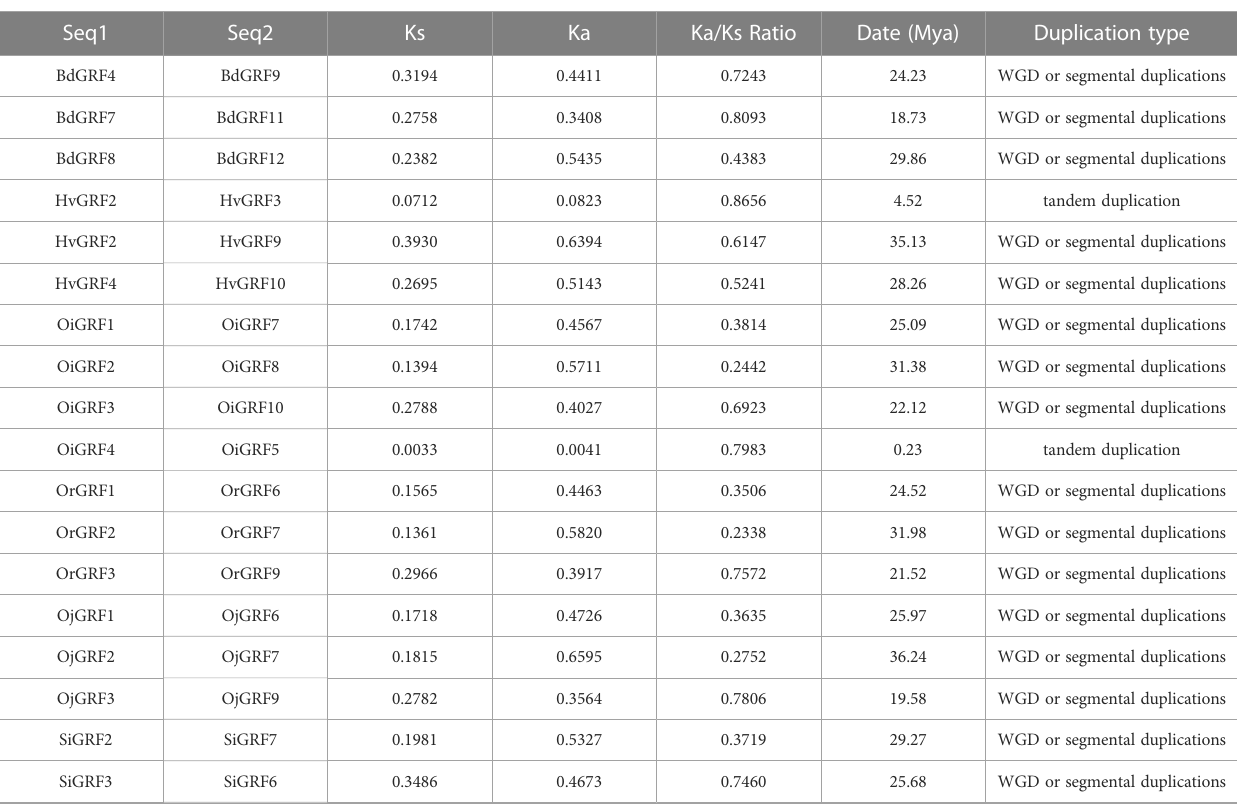
TABLE 1 Ka and Ks values for the duplicated gene pairs in Gramineae crops.